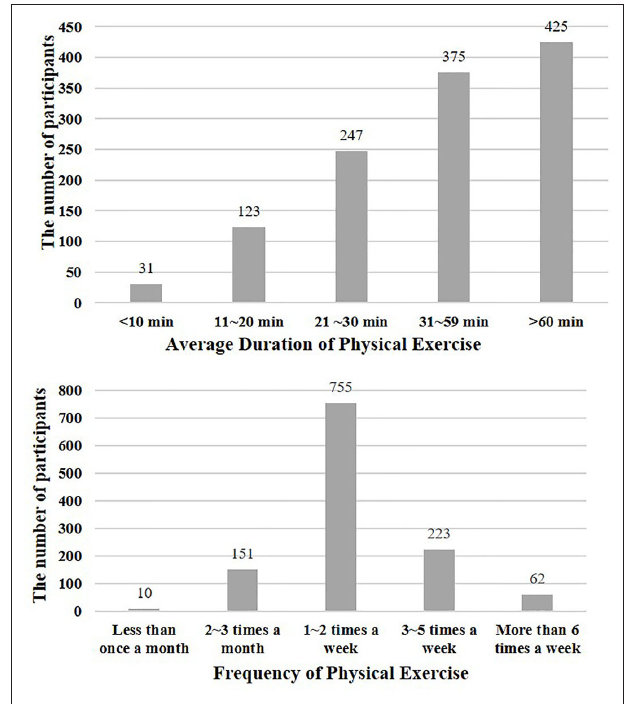
FIGURE 1 | The descriptive statistics of college students’ physical